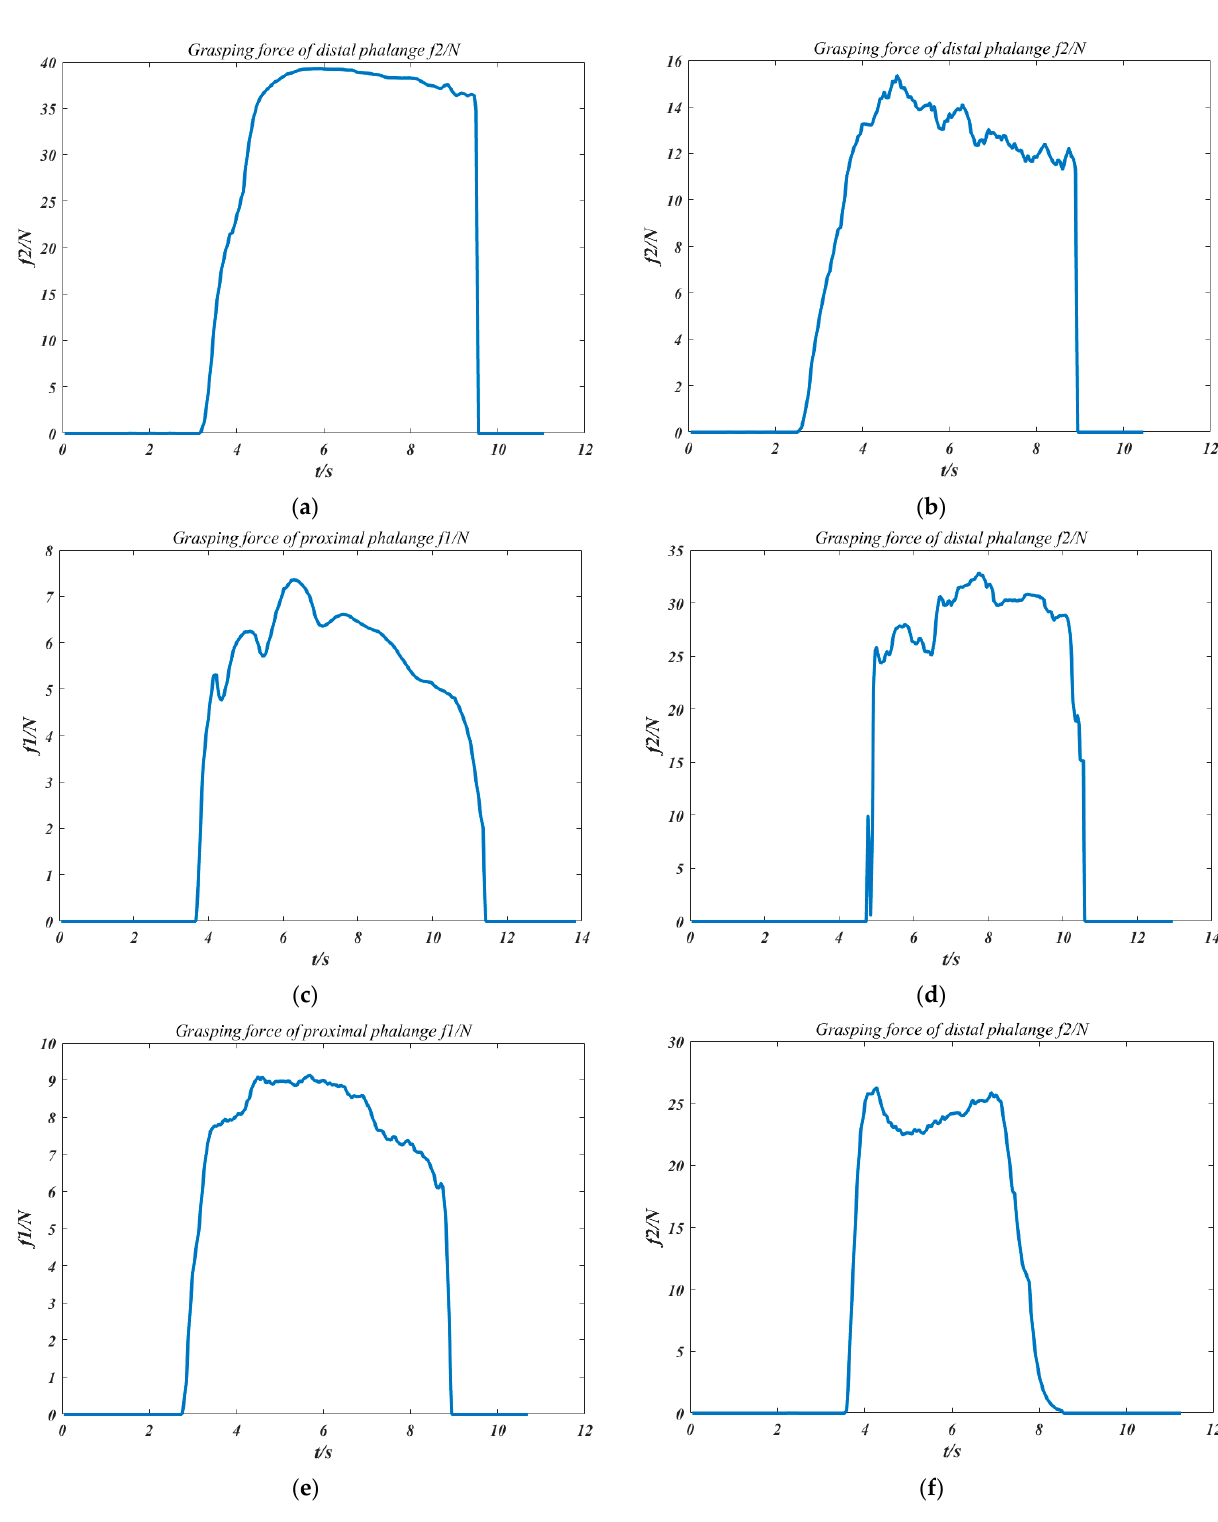
Figure 24. Grasping experiments results: ( a ) Grasping force of distal phalange in experiment scenario 1; ( b ) Grasping force of distal phalange in experiment scenario 2; ( c ) Grasping force of proximal phalange in experiment scenario 3; ( d ) Grasping force of distal phalange in experiment scenario 3; ( e ) Grasping force of proximal phalange in experiment scenario 4; ( f ) Grasping force of distal